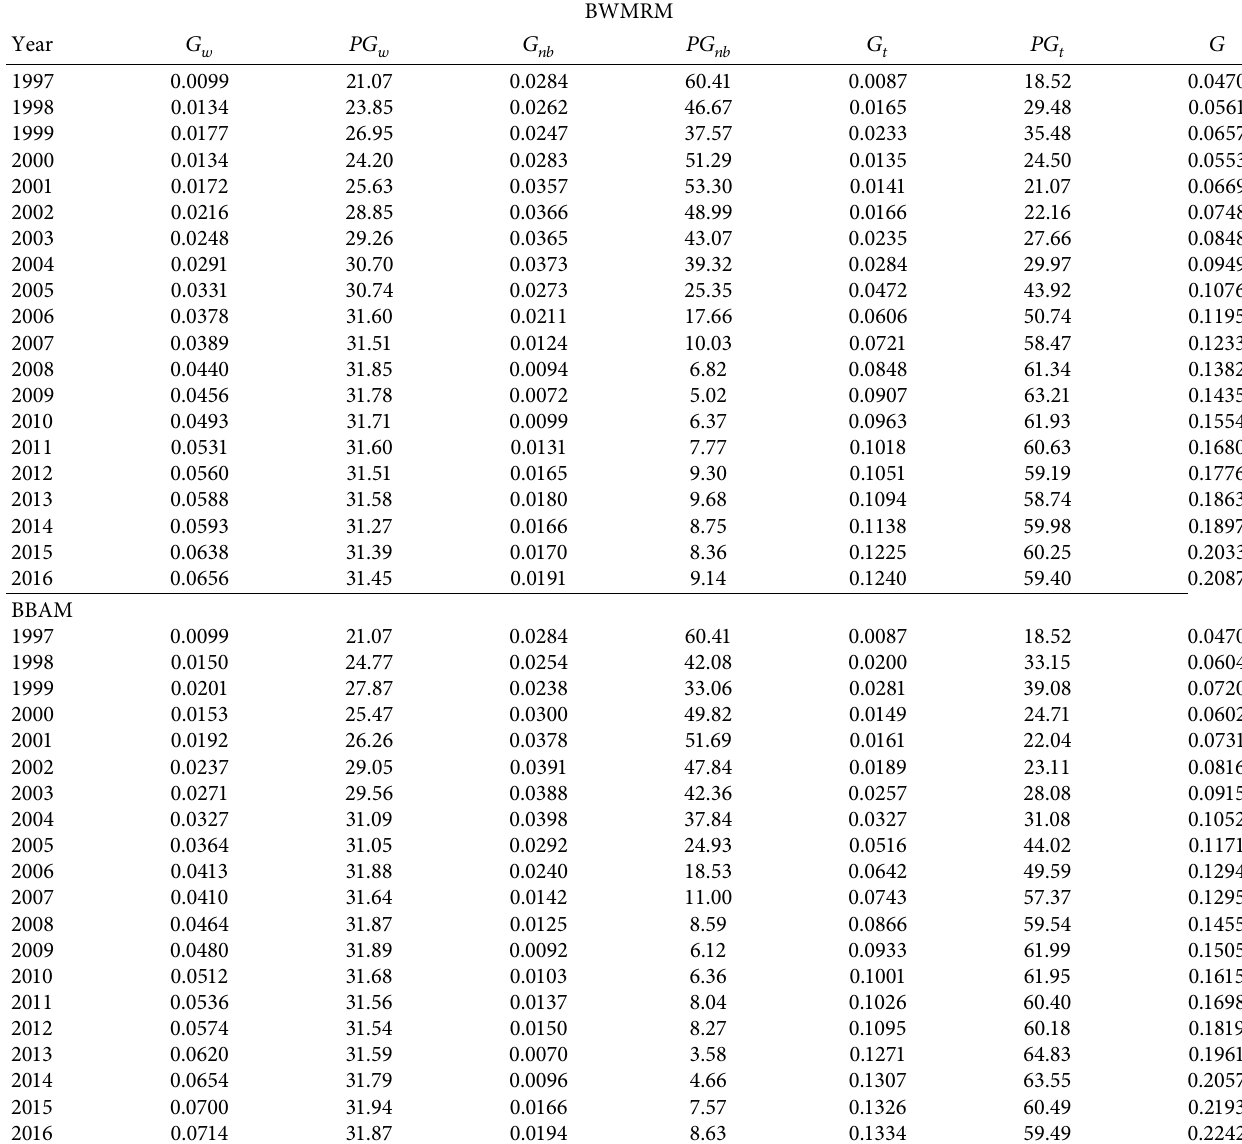
Table 5: The three components of the total Gini ratio of AGTFP in China.